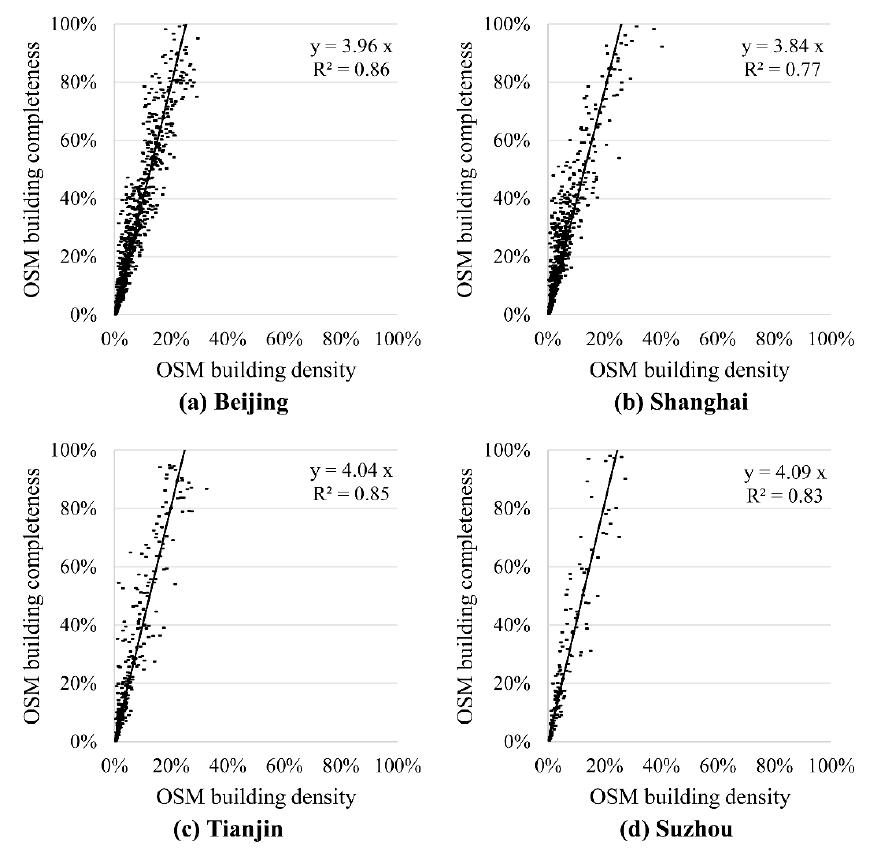
Figure 5. Linear correlations between OSM building density and OSM building completeness for four metropolises in China ( a – d ).